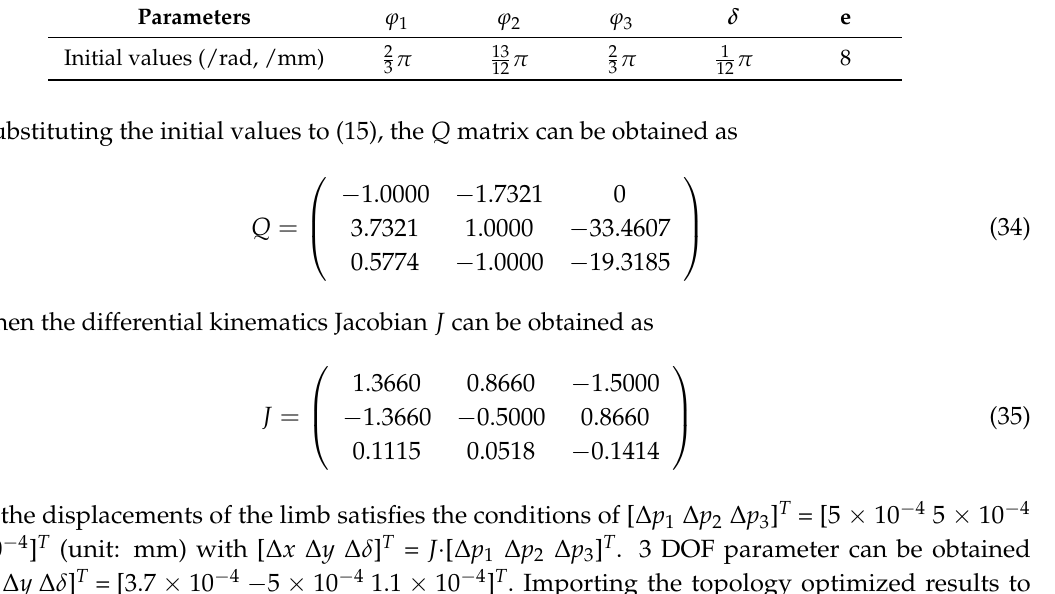
Table 5. The initial values of differential Jacobian matrix.